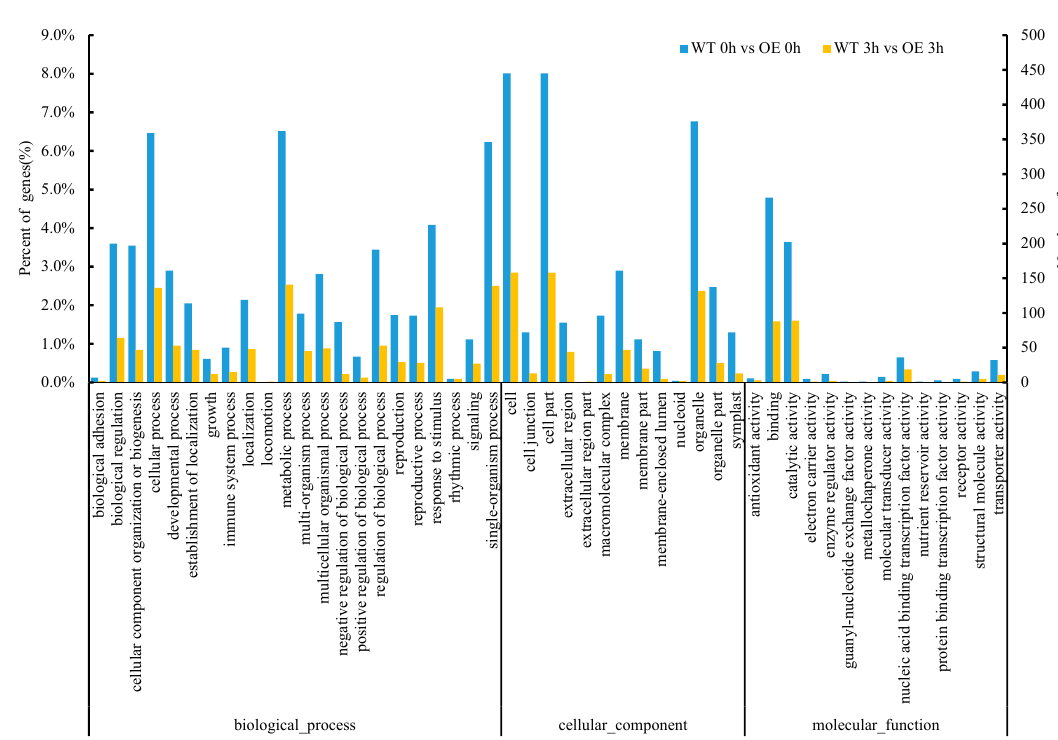
Figure 6. Gene Ontology (GO) classification of WT and ThTrx5 transgenic lines under salt treatment for 0 h and 3 h.